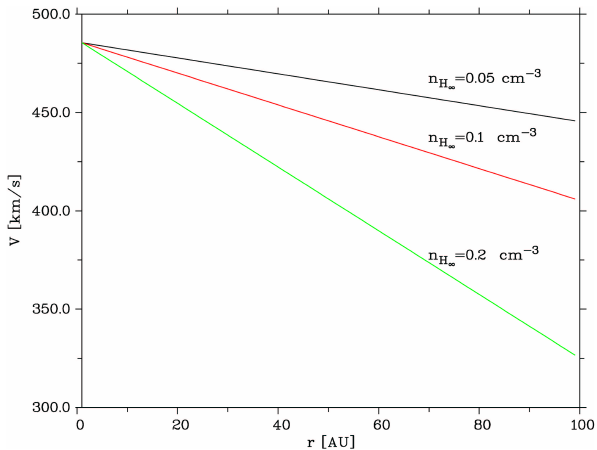
Fig. 5. The dependence of the radial solar wind speed decelera- tion on the atomic hydrogen density in the interstellar medium. The solar wind speed ( y − axis) is the sum of the undisturbed bulk ve- locity of the solar wind V w and the perturbation v r (see Fig. 3). The solar wind speed decreases is shown for three different H-atom = 0 . 05 , 0 . 1 , 0 . 2cm − 3 represented by number densities, e.g. n H ∞ the black, red and green curve,